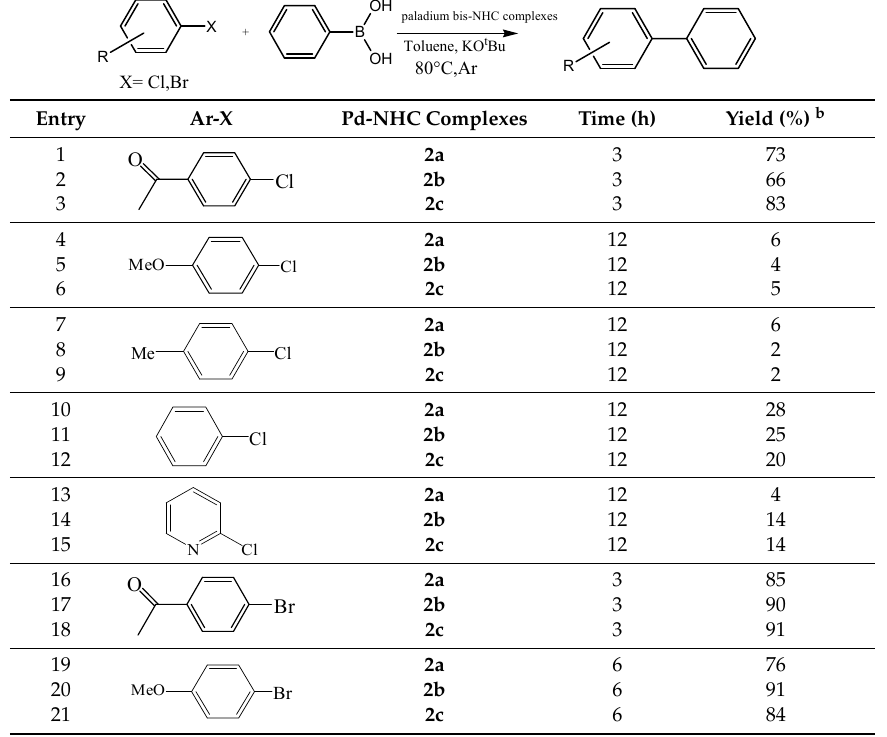
Table 2. The Suzuki coupling reaction of aryl chlorides/bromides with phenylboronic acid catalyzed by different unsymmetrical palladium-bis-NHCs complexes a .